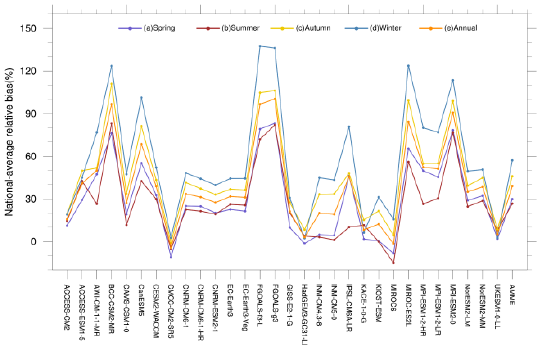
Figure 4. Nationally averaged seasonal and annual relative bias of the CMIP6 models.